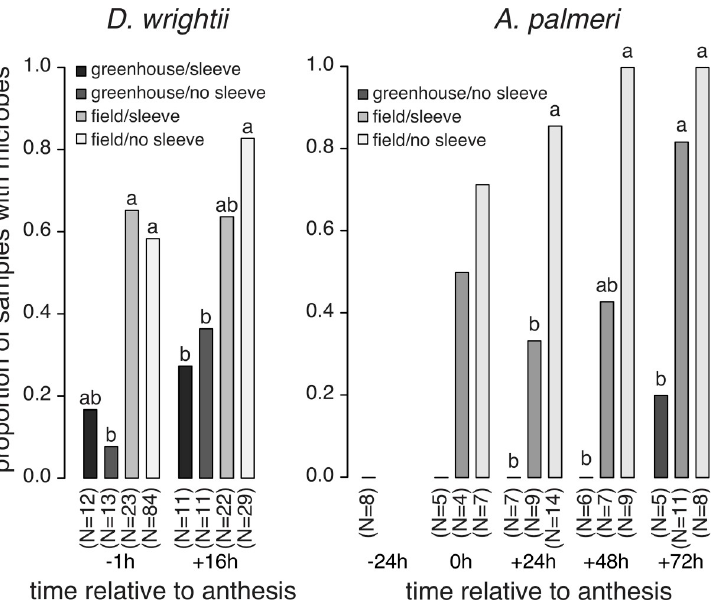
Fig 1. Proportion of D . wrightii and A . palmeri flowers containing nectar microbes (bacteria and fungi; one nectar sample per flower). Nectar was collected from plants in field or greenhouse environments, at different time points relative to anthesis, and with or without exclusion of flower visitors ("sleeve", "no sleeve"). Different letters assigned within a time category indicate statistically significant differences (Tukey HSD, p < 0.05).